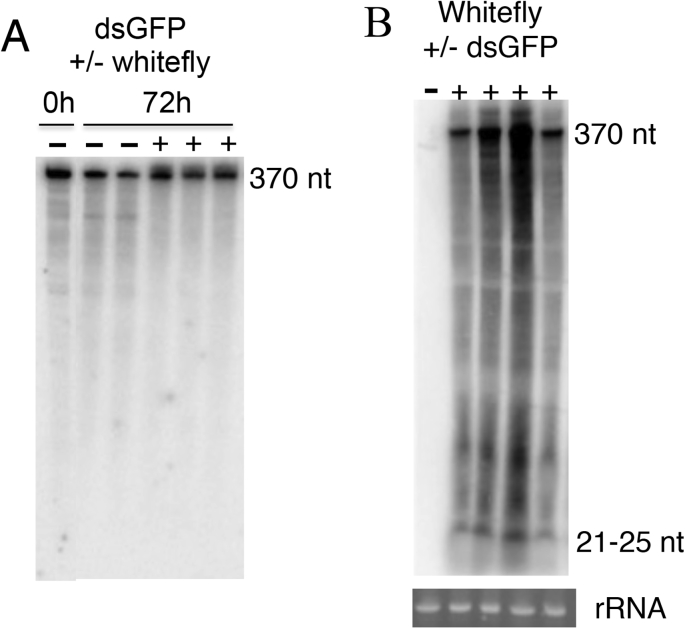
Northern blot analyses of ds-GFP administered to whiteflies via artificial diet. (A) Northern blot of diet supplemented with 1 μg ds-GFP μl−1 and harvested immediately (0 h) and after incubation for 72 h without whiteflies (−) or with whiteflies (+), with 100 ng RNA loaded per well. (B) Northern blot of whiteflies that had fed on two diets containing ds-GFP (+) or ds-GFP-free diets (−), with 20 μg whitefly total RNA loaded in each lane and Sybr-Gold stained rRNA as loading control. The LMW RNA hybridization protocol was used for both blots.